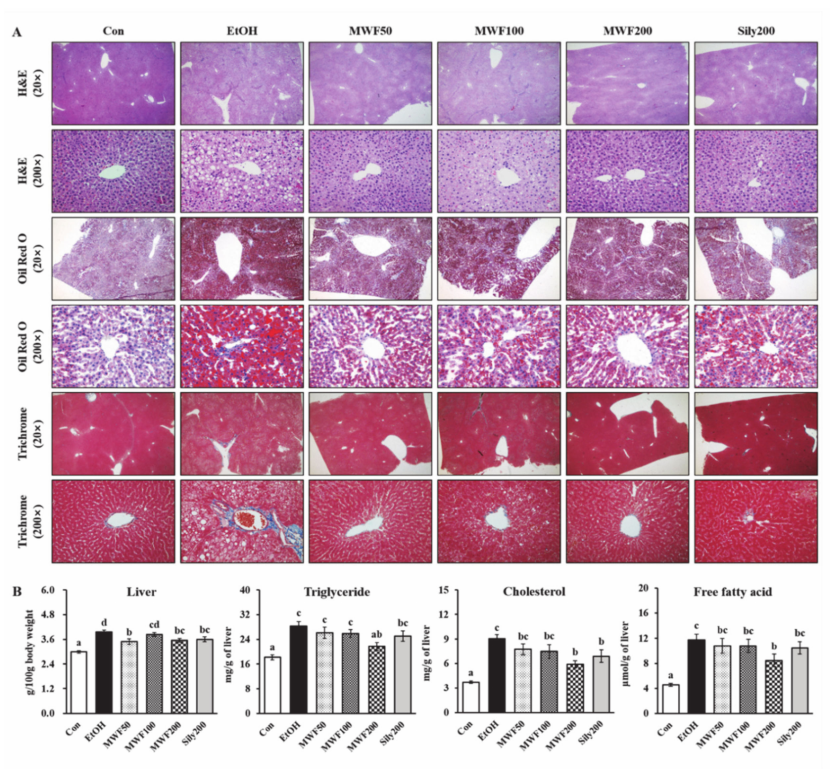
Figure 1. E ff ects of MWF on hepatic histopathological alterations ( A ), relative liver weight ( B ), and hepatic lipid contents ( B ) in chronic alcohol-fed rats. Mean ± SE. Statistical significance was determined by one-way ANOVA, followed by Duncan’s multiple range test. Values not sharing a common letter (a, b, c, d) above the bars are significantly di ff erent among the groups at p <